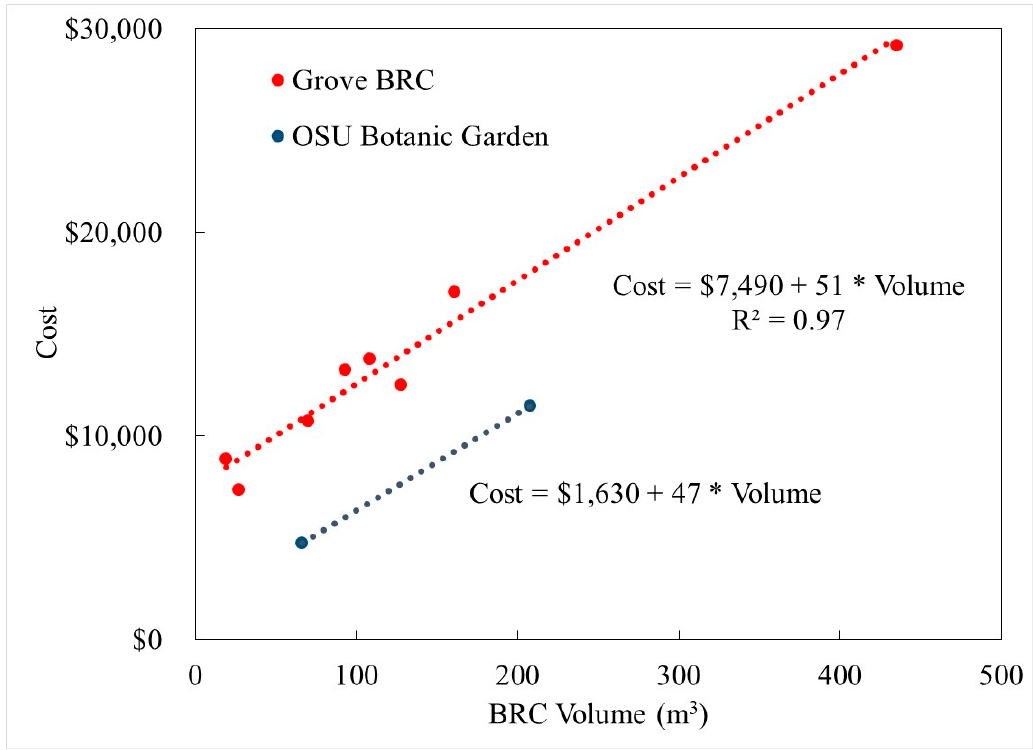
Figure 7. BRC construction cost as a function of volume [37].